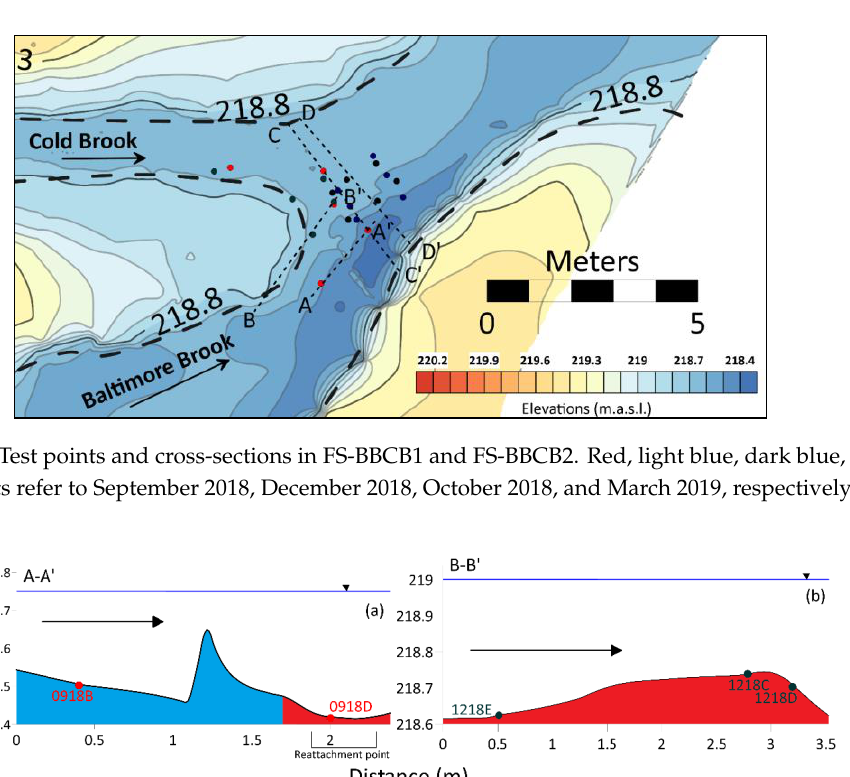
Figure 15. Longitudinal sections A –A’ and B–B’ from Figure 14, with red fill depicting downwelling and blue fill depicting upwelling.